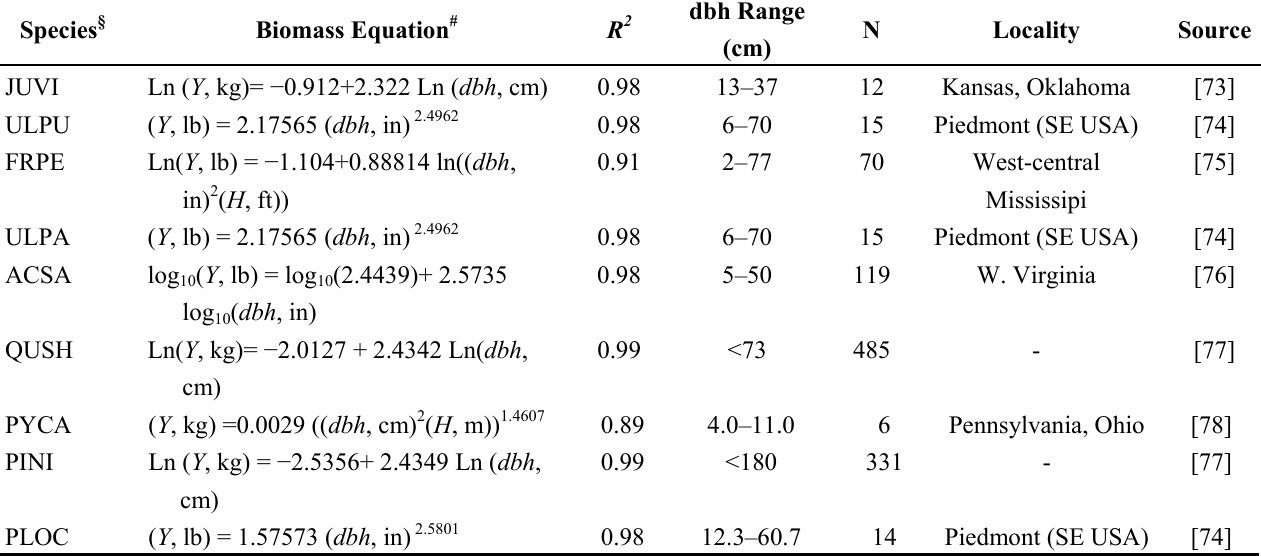
Table 7. Biomass equations used to estimate individual tree aboveground